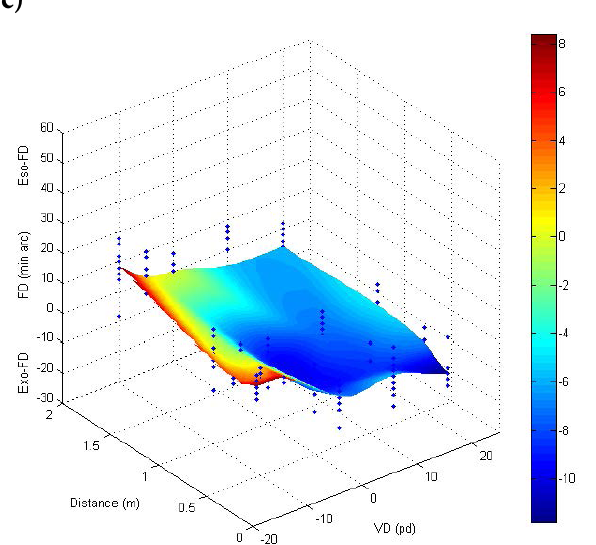
Figure 4 . Pseudo-3D plots for surfaces of forced vergence disparity for three subjects . a ) Subject 1, b ) Subject 2 and c ) Subject 3. The colour bar on the right side represents fixation disparity in min arc .